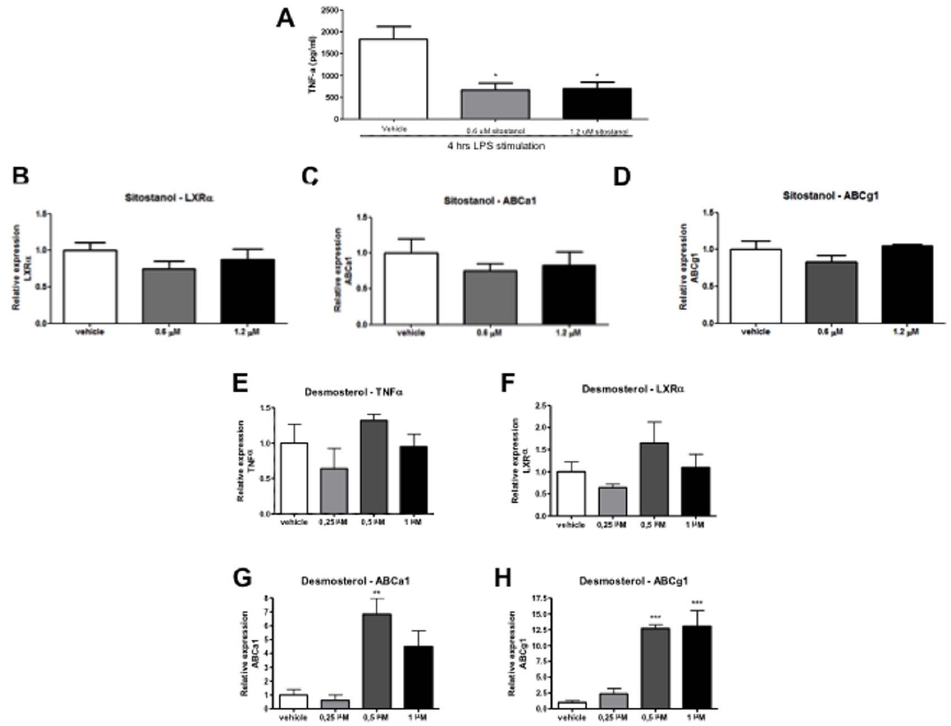
Figure 7. Effect of plant stanols on macrophages invitro. Changes in Tnf- a concentrations in supernatant and LXR target gene expression of bone marrow derived macrophages after incubation with sitostanol (0.6 and 1.2 m m) or desmosterol (0.25, 0.5 and 1.0 m m) and 4 h LPS stimulation. (A) Tnf- a concentrations, (B) LXR a mRNA, (C) Abca1 mRNA, and (D) Abcg1 mRNA expression after sitostanol exposure, (E) Tnf- a mRNA, (F) LXR a mRNA, (G) Abca1 mRNA, and (H) Abcg1 mRNA expression after desmosterol exposure. Data were set relative to cells incubated with cyclodextrin (carrier control). *P , 0.05; **P , 0.01; ***P , 0.001.